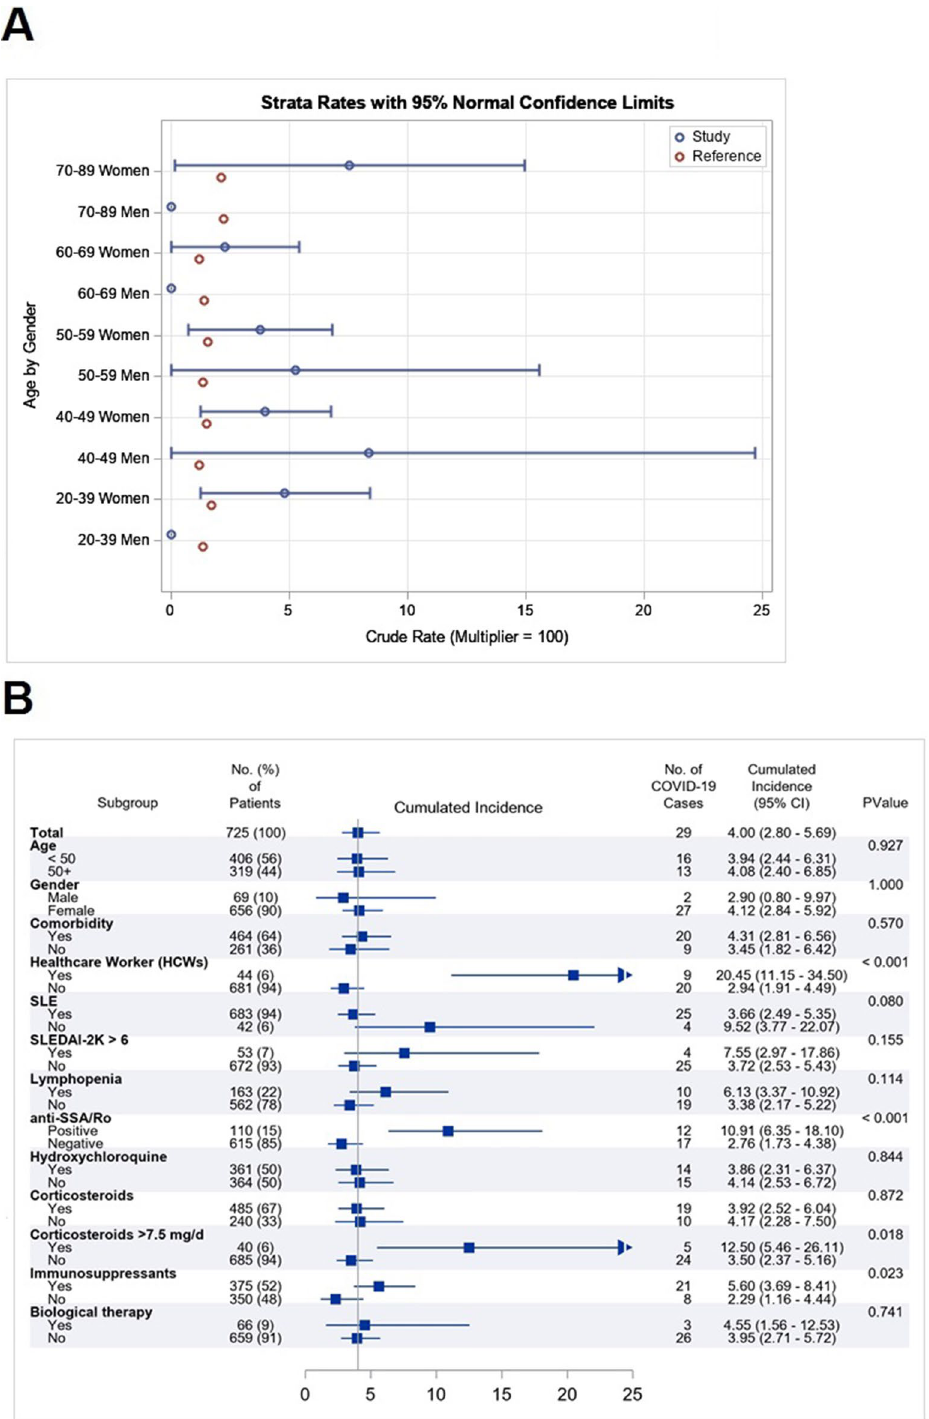
Figure 1. Covid-19 incidence in Lupus Disease. ( A ) Age and gender-stratified COVID-19 incidence estimates in lupus patients (blue), compared with reference population (red). ( B ) Forest plot of COVID-19 cumulated incidence according to several subgroups of